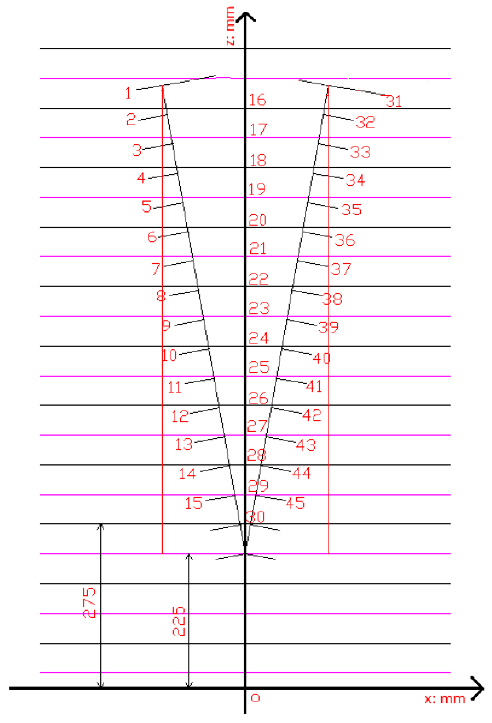
Figure 3. 2D x - z coordinate system (each line is 50 mm separated).